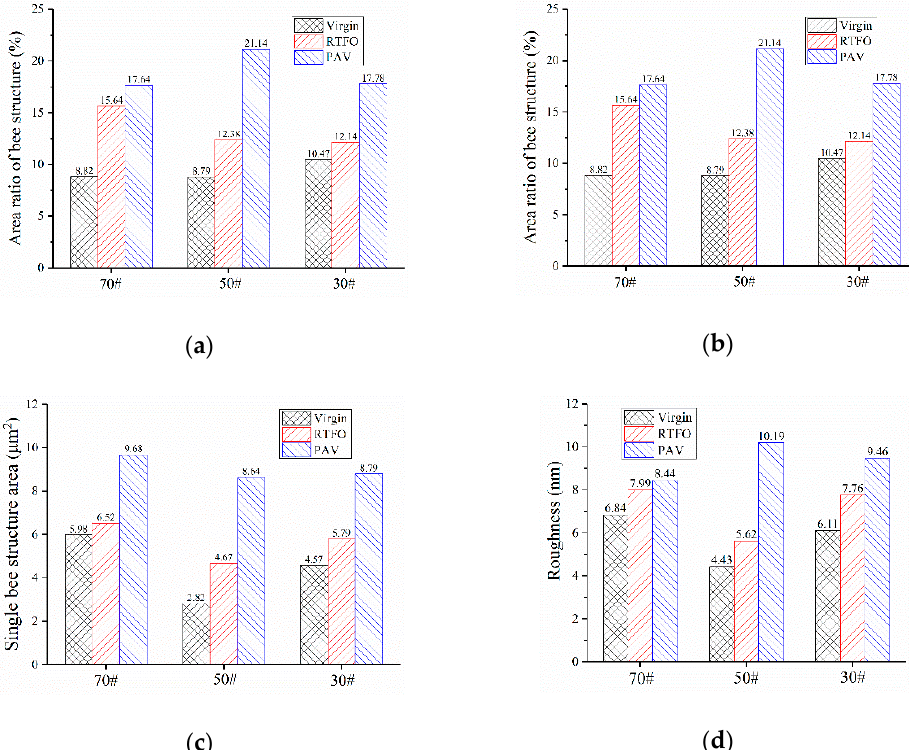
Figure 2. Changes in the micromorphology of bitumen before and after aging: ( a ) Bee structure number; ( b ) area ratio of bee structure; ( c ) single bee structure area; ( d ) roughness.